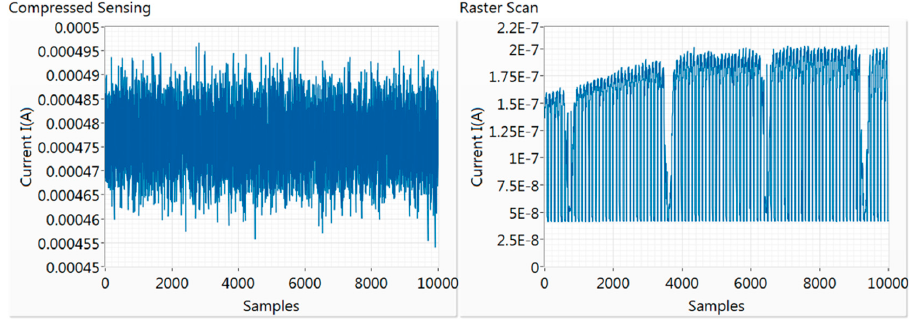
Figure 5. On the left, the current measurements for 10,000 patterns for compressive sampling—all the values are within a very small value range. On the right, the current measurements for a 10,000-pixel point-by-point current map, where the values have a range of 1 order of magnitude.